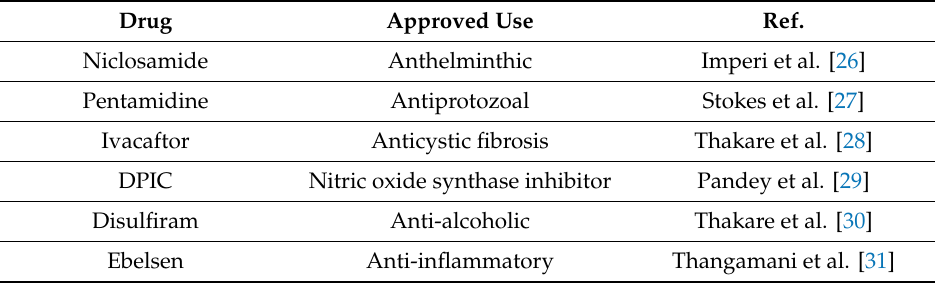
Table 8. FDA approved drugs with identified antibacterial activity.